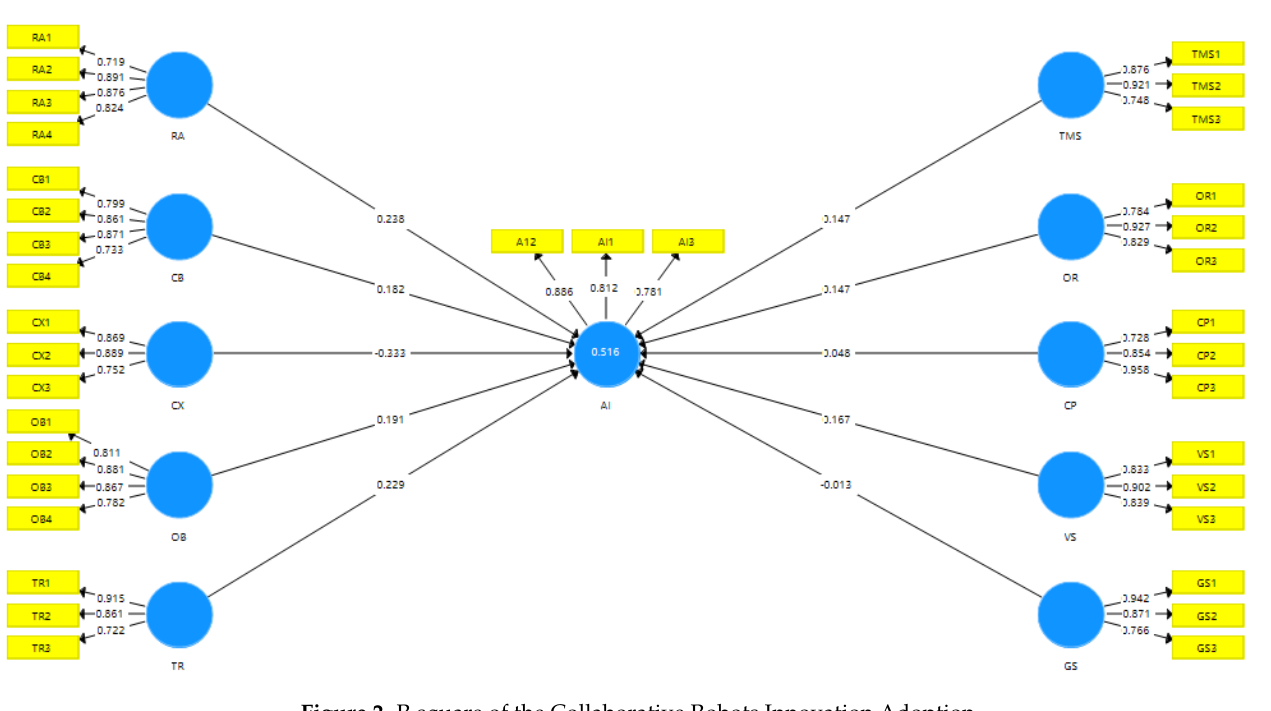
Figure 2. R square of the Collaborative Robots Innovation Adoption. Table 2. Reliability and Validity Coefficients for